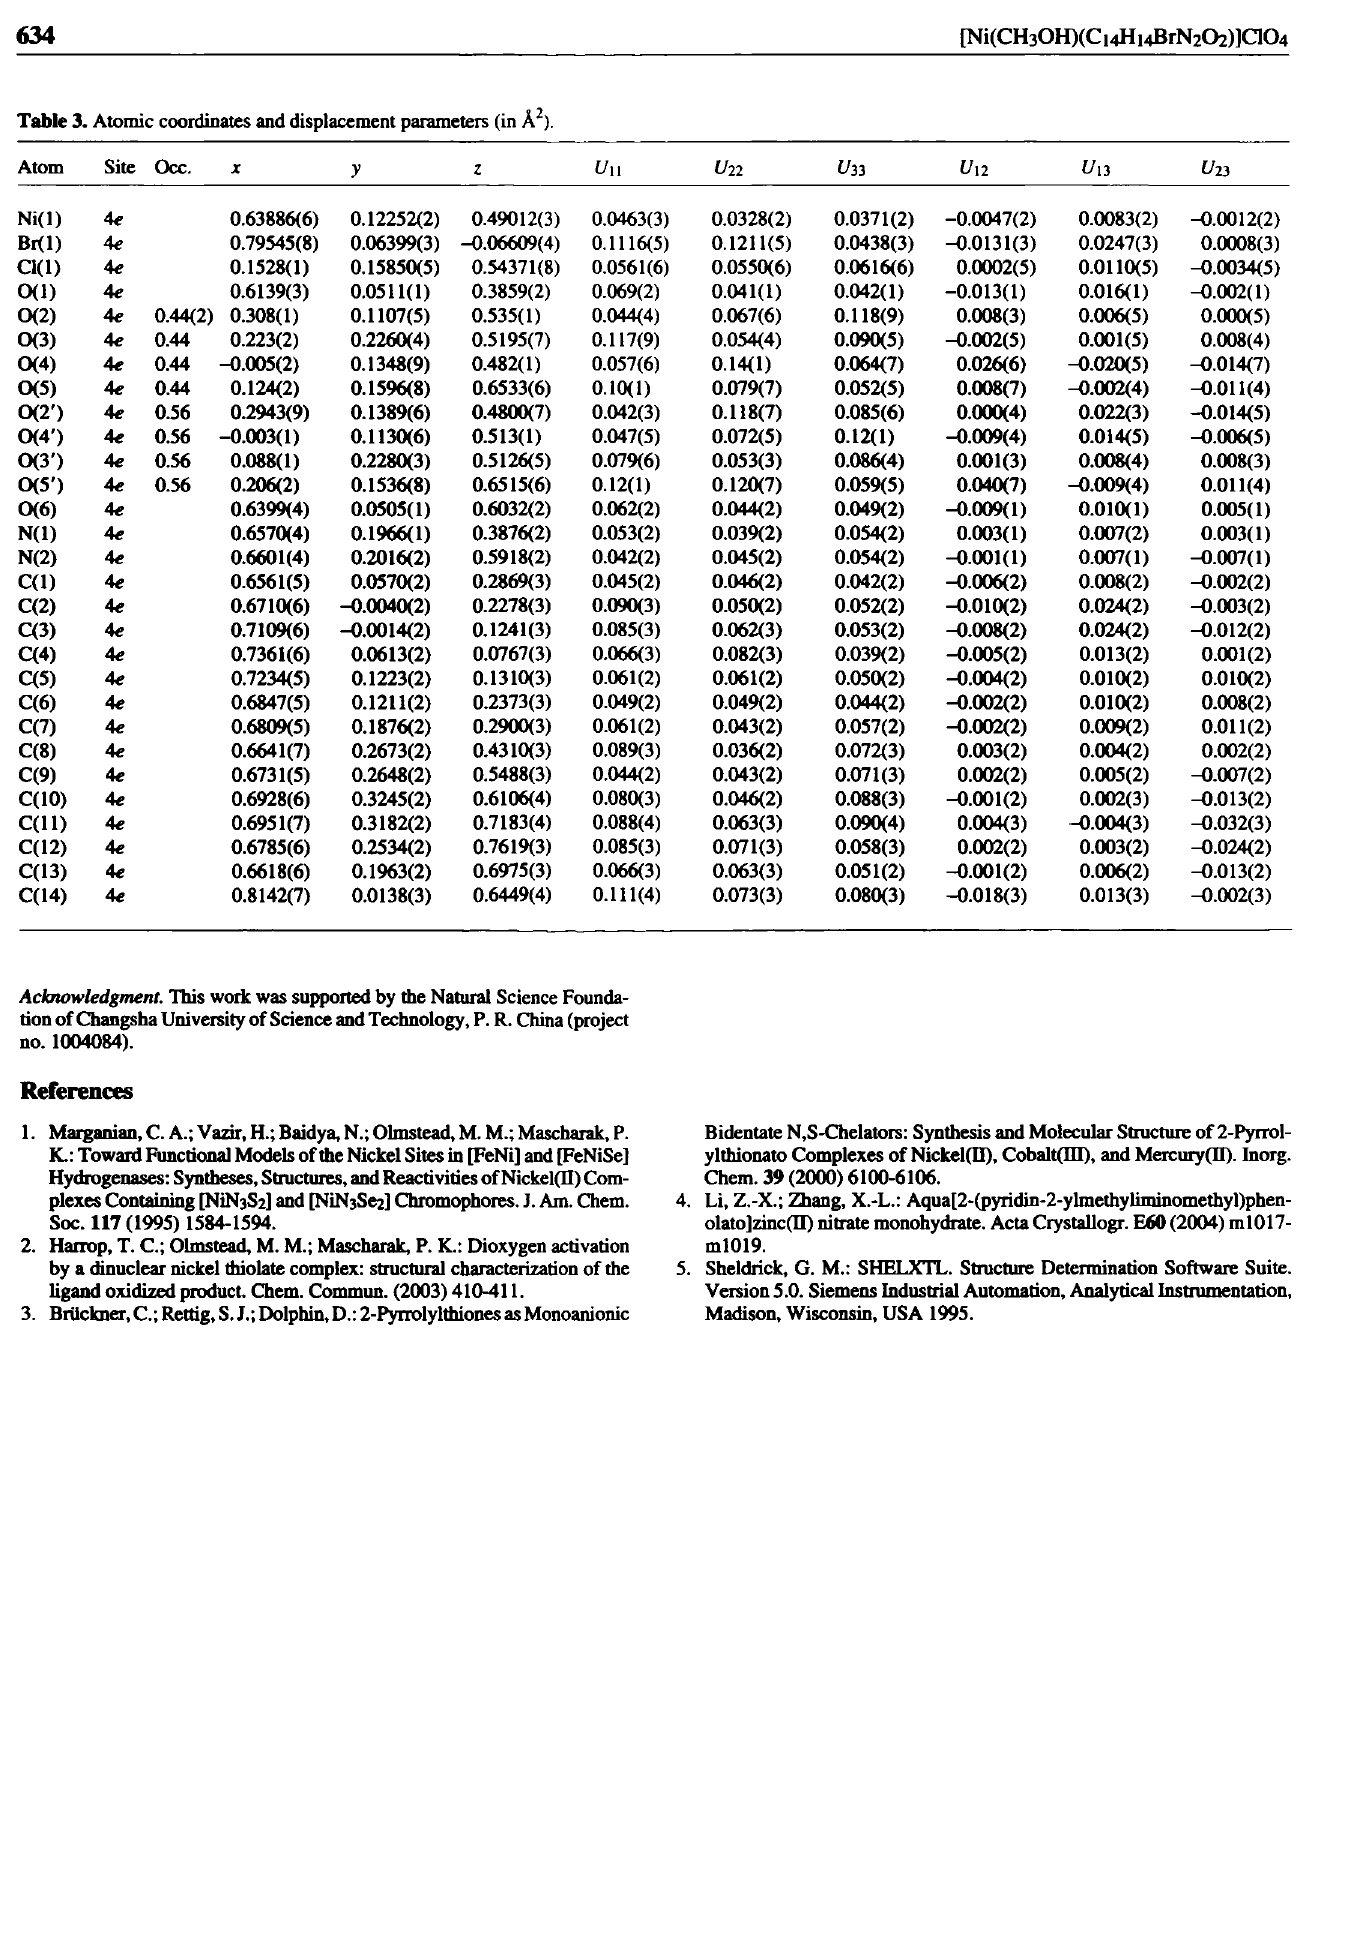
Table 3. Atomic coordinates and displacement parameters (in A 2